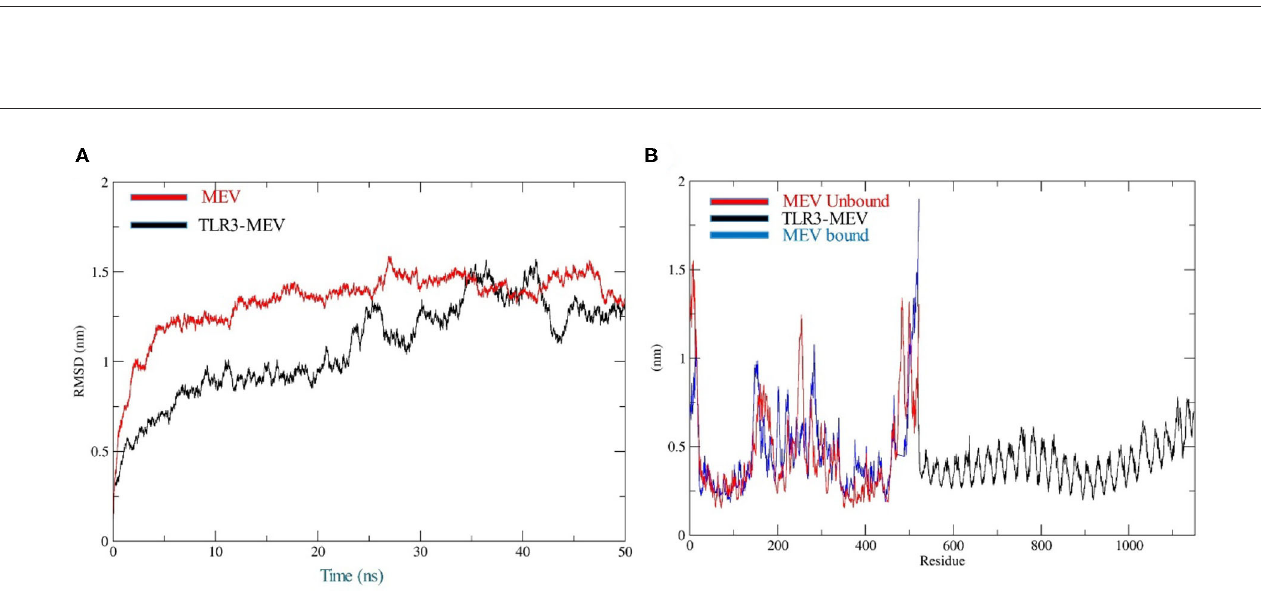
FIGURE3 Molecular dynamics simulation analysis at 50-ns MD simulation. (A) Analysis of RMSD trajectories for MEV-TLR3 complex (Black) and MEV (Red), relative to the backbone. The RMSD plot showed structural stability of the complex with minimum deviations; (B) Analysis of RMSF trajectories for MEV-TLR3 complex (Black), MEV (Red) and MEV bound (Blue) to TLR3. The RMSF plot shows the flexibility of interacting side-chain